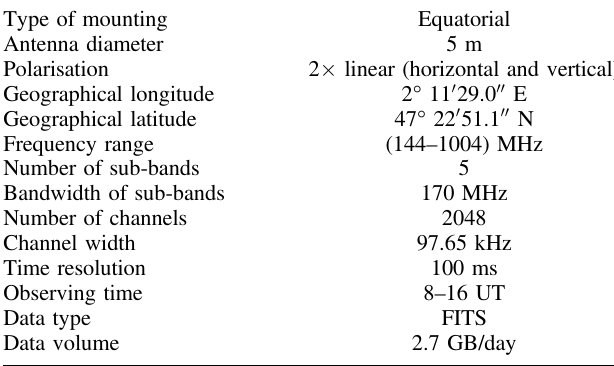
Table 1. ORFEES radio spectrograph